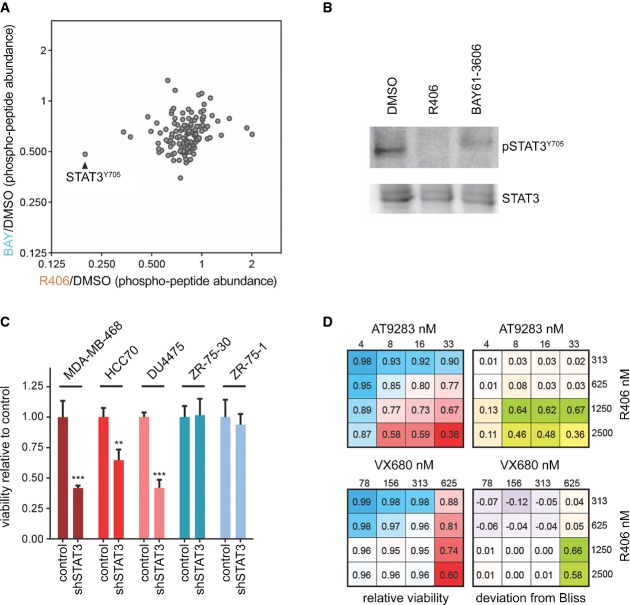
STAT3 is a critical downstream SYK effector
A Quantitative phosphoproteomics of MDA-MB-468 cells treated with indicated SYK inhibitors or vehicle for 6 h. Fold change in relative phosphopeptide abundance compared to DMSO is indicated.

B Western blot of MDA-MB-468 cells treated as in (A).

C MDA-MB-468, HCC70, DU4475 (basal) or ZR-75-1, and ZR-75-30 (luminal) cells infected with STAT3 shRNA or non-targeting control shRNA were grown for 4 days, and cell viability was measured via Celltiter Glo. **P < 0.01, ***P < 0.01, two-sided Student's t-test. n = 3.

D MDA-MB-468 cells treated in dose–response matrix with SYK inhibitor R406 and two different AURKA inhibitors (AT9283 and VX680). Relative cell viability (left) and synergy as expressed by deviation from the Bliss independence model (right) are indicated.